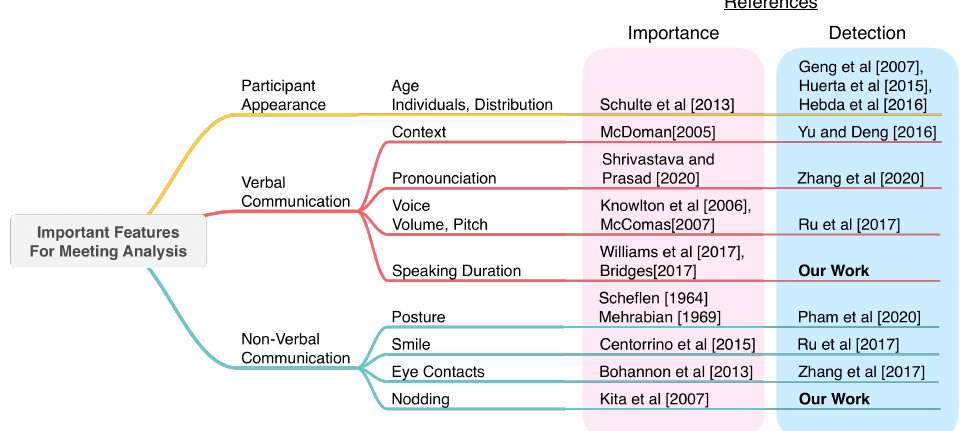
Figure 2. A tree map summarizing important activities for meeting analysis and the position of our